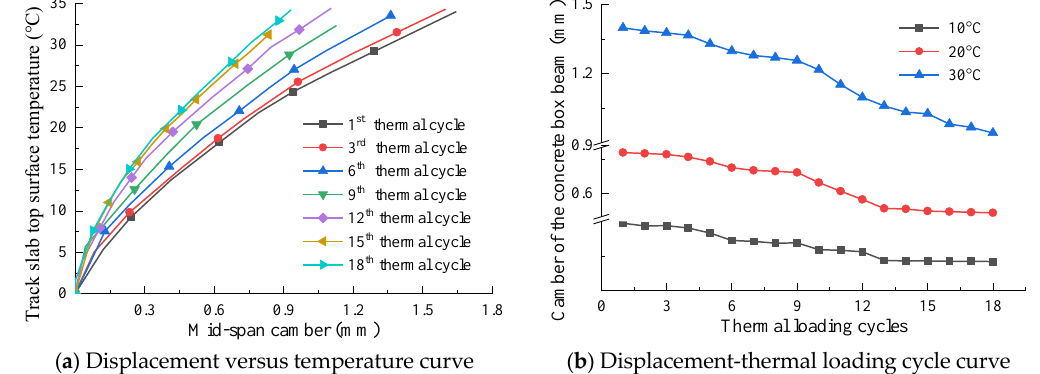
Figure 18. Mid-span displacement of the concrete box beam.